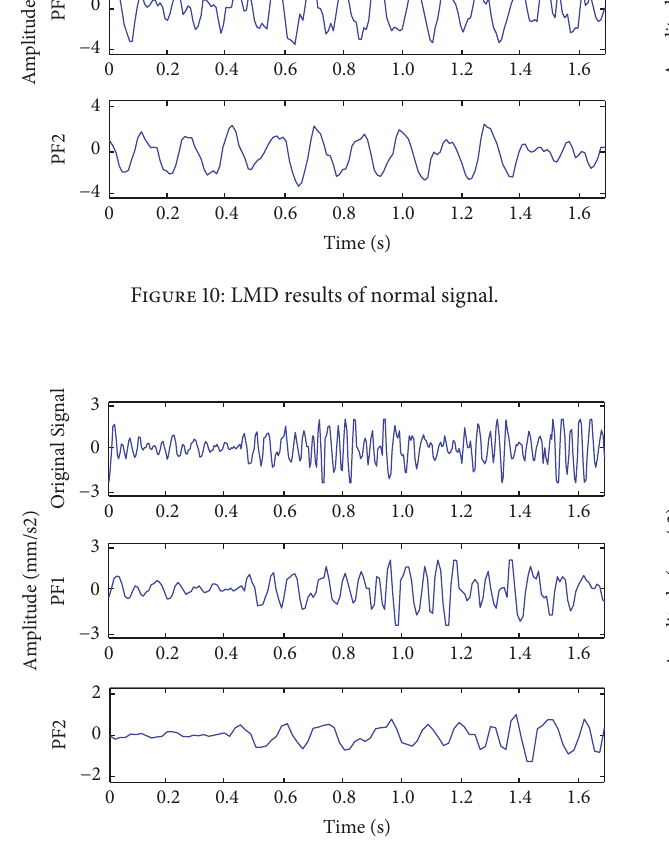
Figure 11: LMD results of broken tooth fault signal.